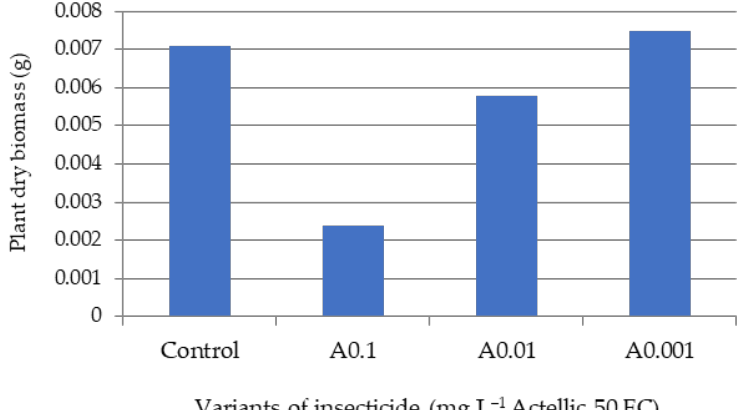
Figure 3. Average leaf length of sorghum after 5 days of exposure.